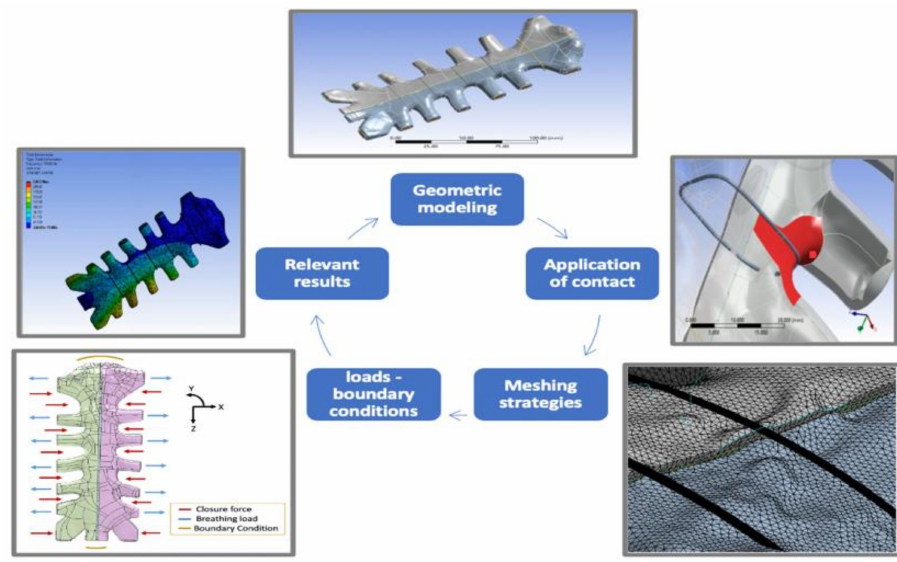
Figure 2. The finite element steps for simulating sternal fixation models.